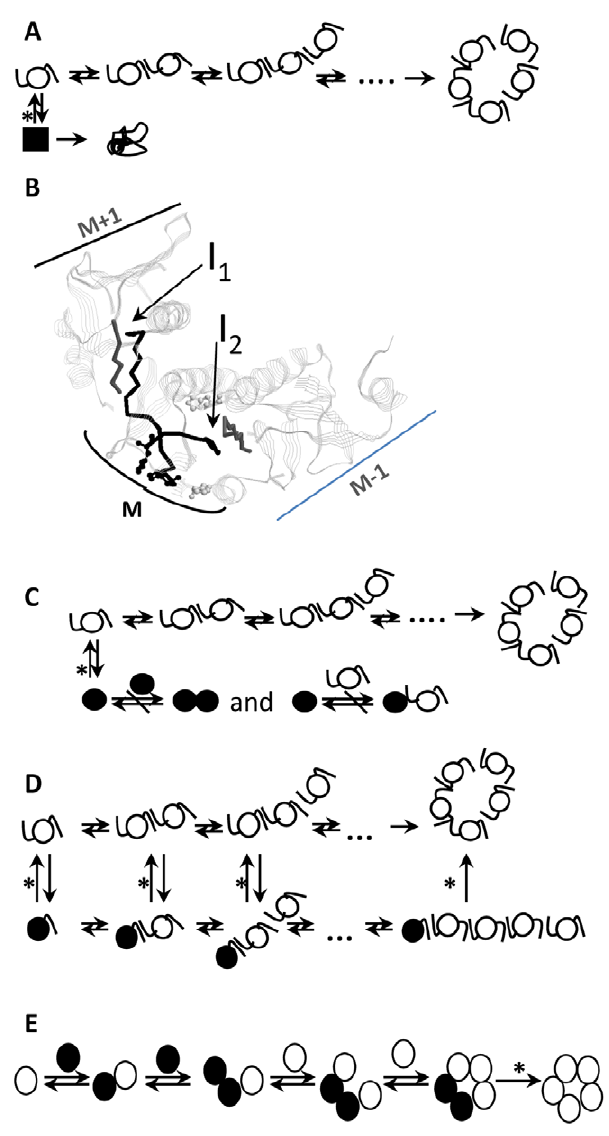
Figure 2. Scenari of the steps possibly inhibited by the low pH during the reassembly of CxtB. Each monomer is represented by a circle. The deprotonated and the protonated CtxB monomers are indicated in white and in black, respectively. In scenari 1, 2 and 3, the b - strands constituting the two subunit interfaces (25–33 a.a. and 97–103 a.a.) are indicated by a line only when they are capable of associating. If the association is impaired by the low pH, the strands of the interfaces are not represented. The native CtxB 5 is represented as a ring of five monomers according to the x-ray crystallographic structure ( 10 ). 2A. Scenario 1. The folding of the CtxB monomer is inhibited by the low pH. The protonated (black square) and the deprotonated CtxB (white circle) monomers have two different folds, and only the deprotonated CtxB monomer persue the assembly process. The protonated CtxB monomer misfolds irreversibly. 2B. CtxB 5 interfaces and histidine residues. For simplicity, out of the five CtxB monomers that composed the native pentamer, only three are shown in strands. Each monomer has two interfaces (Interfaces 1 and 2) involving two different b -strands. The strand number 3 of M (residues 25 to 33) associates with the C- terminal end of the b -strand number 6 of monomer M + 1 (residues 97 to 103) to form the interface 1 (I 1 ). The C-terminal end of the b -strand number 6 of monomer M associates with the strand number 3 of monomer M-1 to form the interface 2 (I 2 ). The four histidine residues are indicated as balls and sticks, histidines 18 and 94 which are located upstream the two b -strands of the interfaces are colored in black.